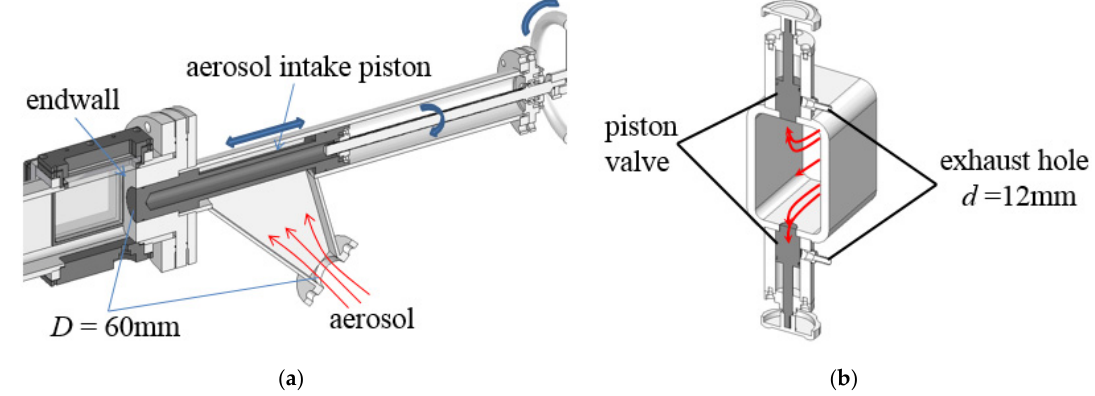
Figure 3. Schematic of aerosol intake process. ( a ) Structure of the aerosol intake section; ( b ) structure of the exhaust valve.